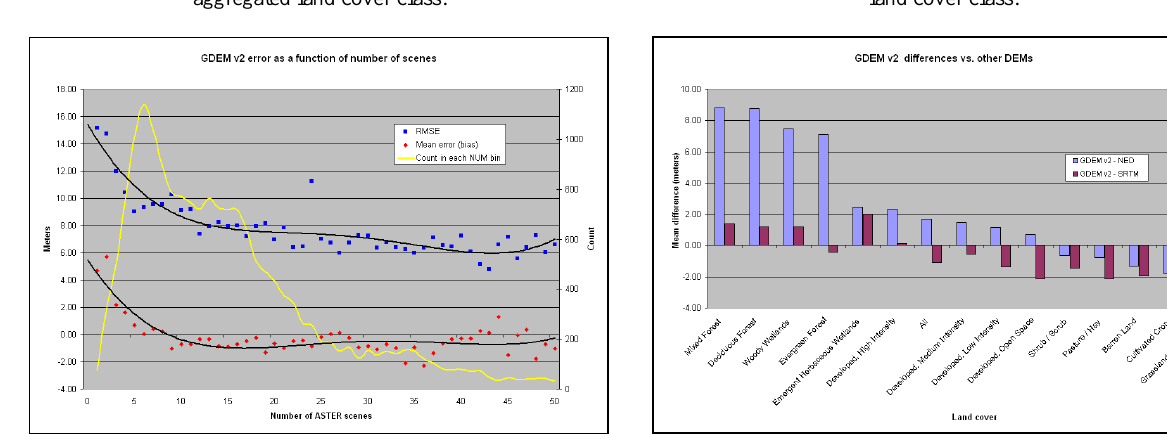
Figure 7. GDEM v2-NED and GDEM v2-SRTM RMSE by land cover class.